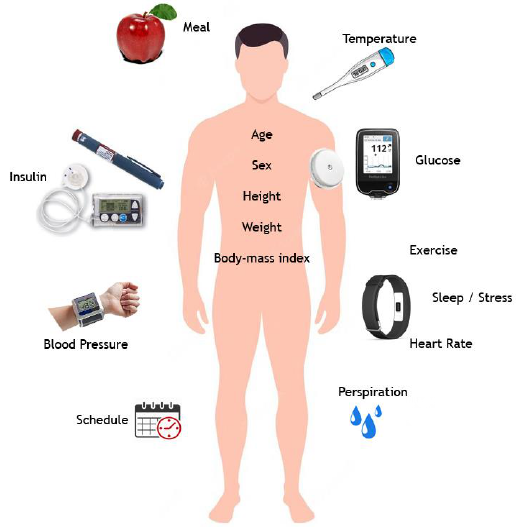
Figure 1. Variables related to DM1 in an IoMT context.